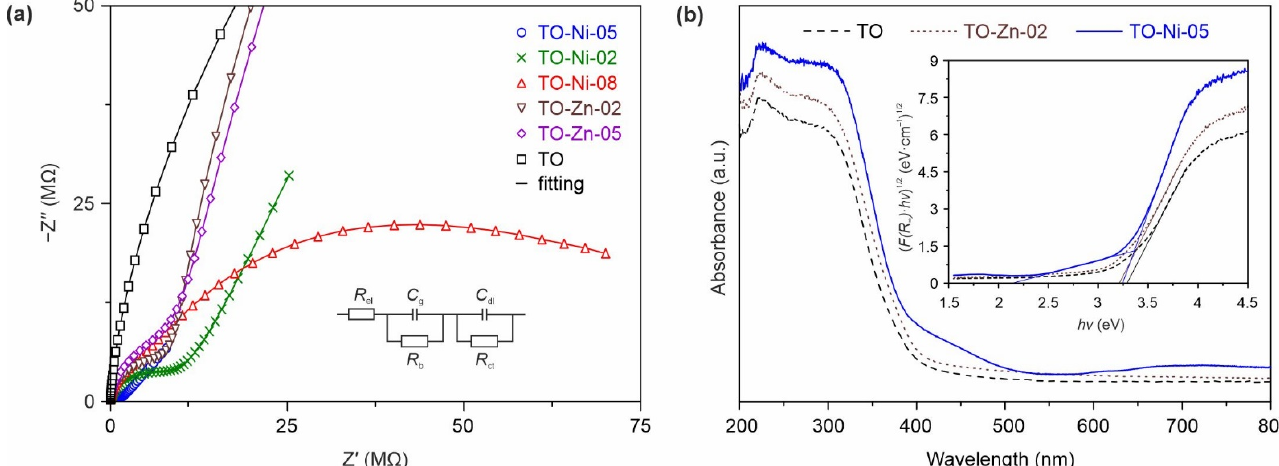
Figure 5. ( a ) EIS spectra (enlarged view) of TiO 2 (B) materials containing different amounts of nickel and zinc and electrical equivalent circuit (inset) for fitting of the experimental impedance data. Symbols represent experiments, whereas lines are fitting results. ( b ) UV–Vis absorption data for TO, TO-Ni-05, and TO-Zn-02 products (inset represents corresponding Kubelka–Munk plots).